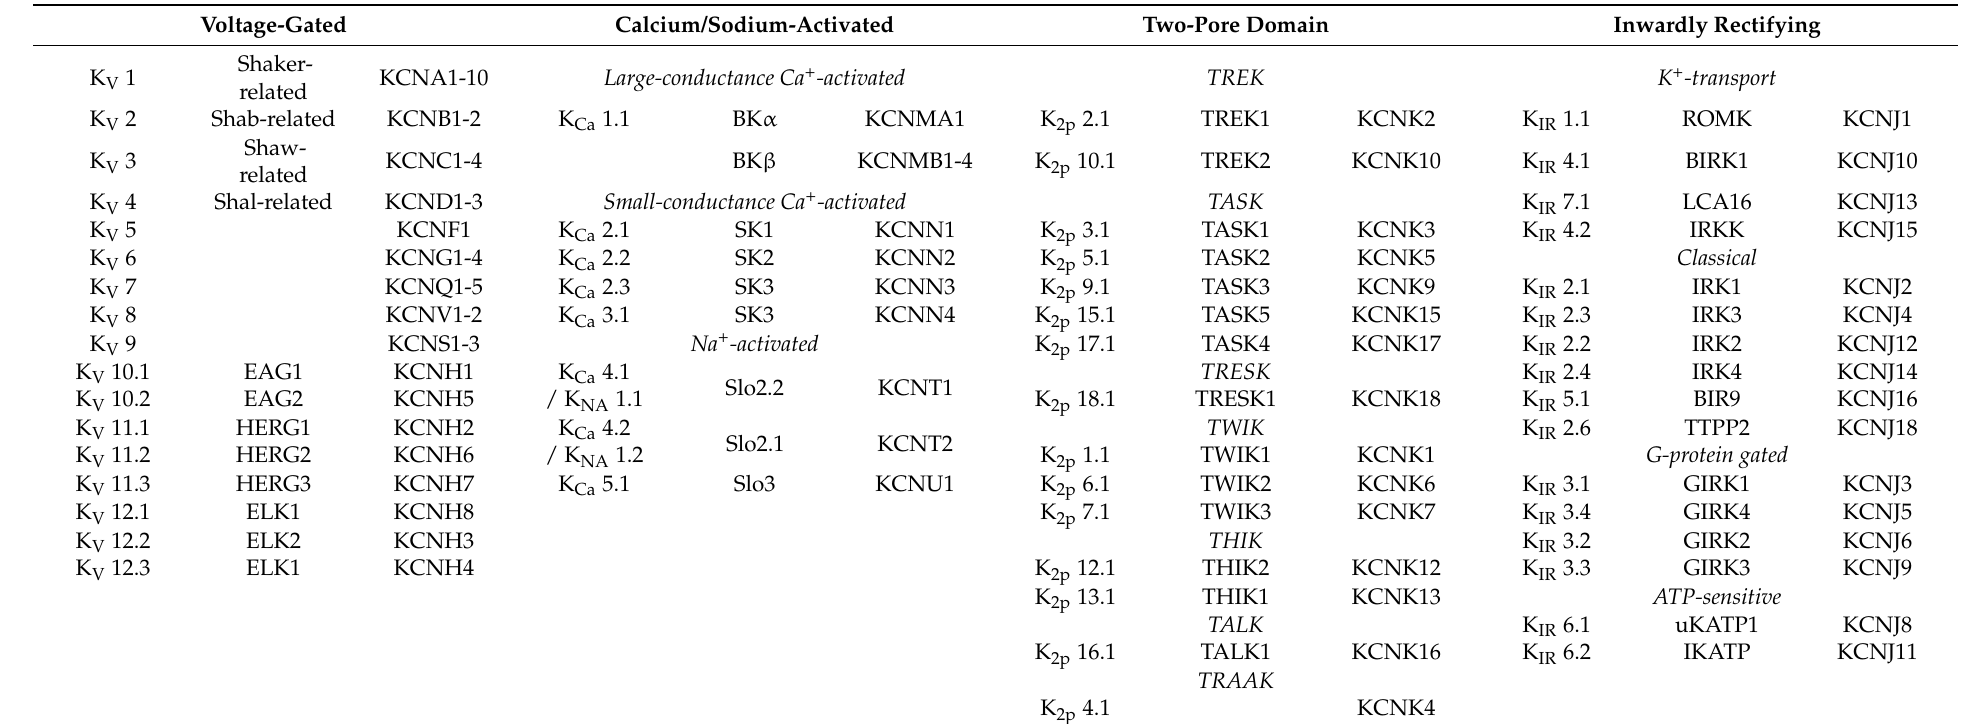
Table 1. Families of Potassium